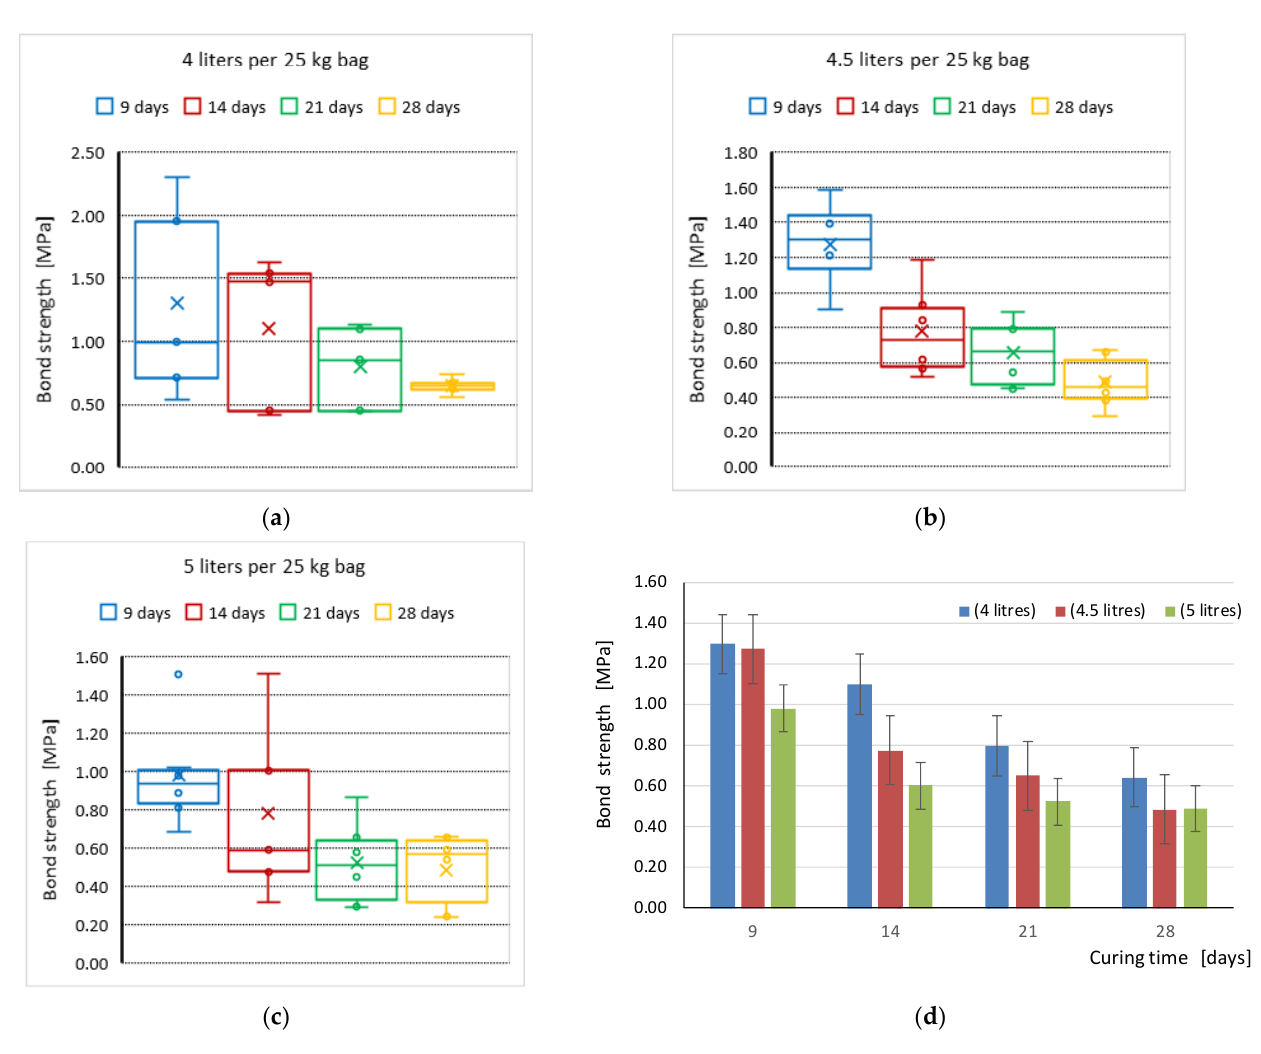
Figure 5. Flexural bond strength in terms of dependence with the curing time (days) of specimens: ( a ) WT_xx_4L series; ( b ) WT_xx_4.5L series; ( c ) WT_xx_5L series; and ( d ) comparison of mean values with standard errors for all tested series.